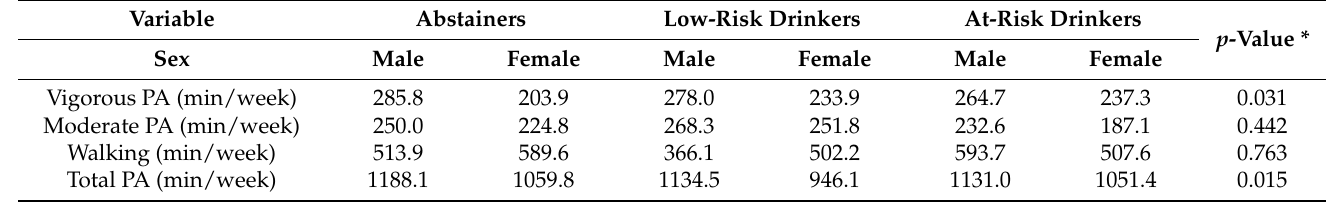
Table 8. Levels of physical activity in students and relations to alcohol consumption